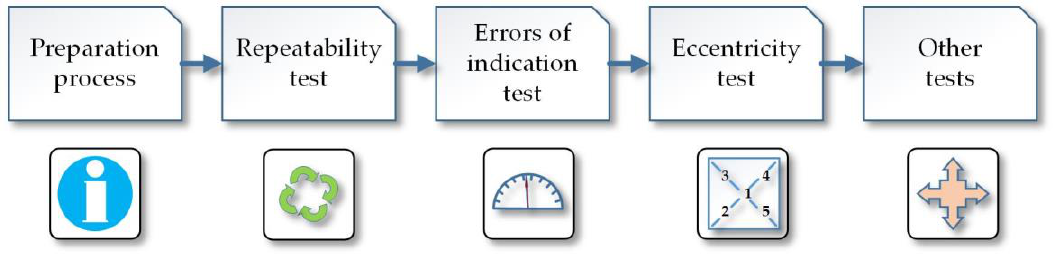
Figure 1. Simplified static calibration process of weighing instruments.